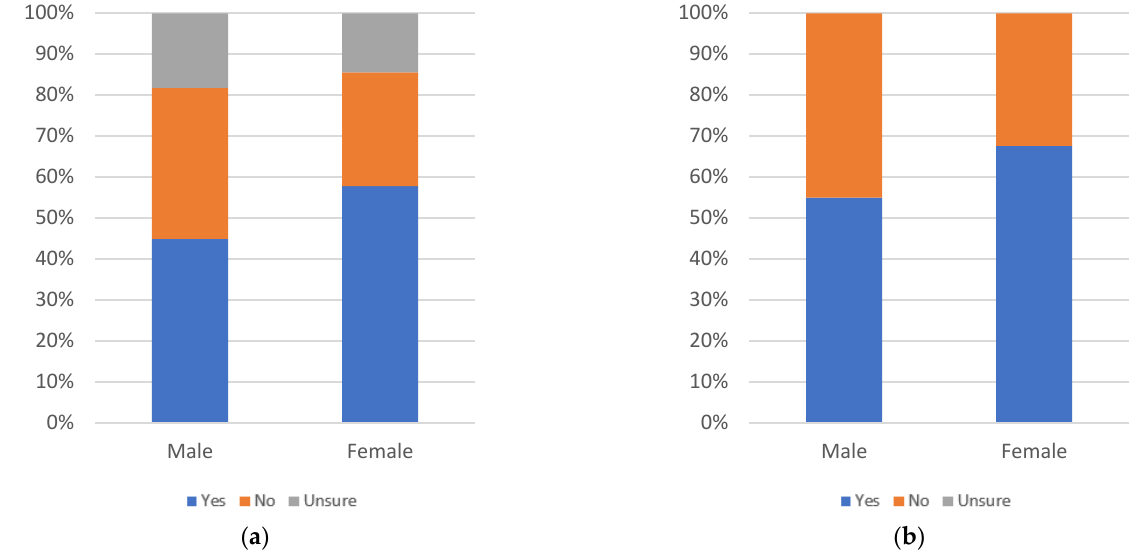
Figure 115. Label trustworthiness judging use, by gender: ( a ) with uncertain respondents (left) and ( b ) without uncertain respondents (right).